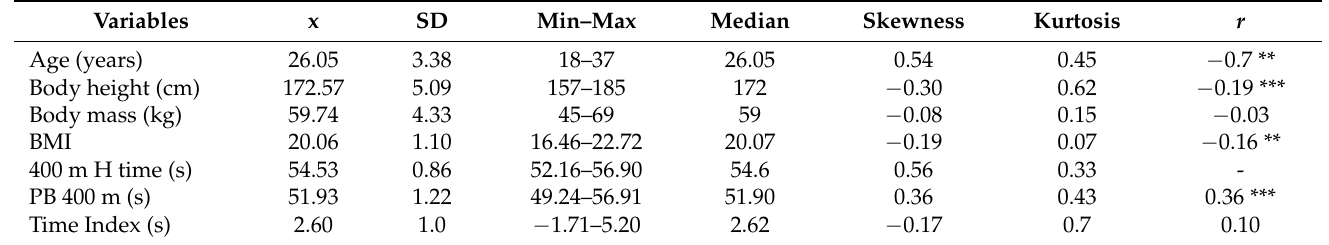
Table 2. Descriptive statistics of demographic, anthropometric, and basic sports achievements in the entire group of athletes ( n = 283).